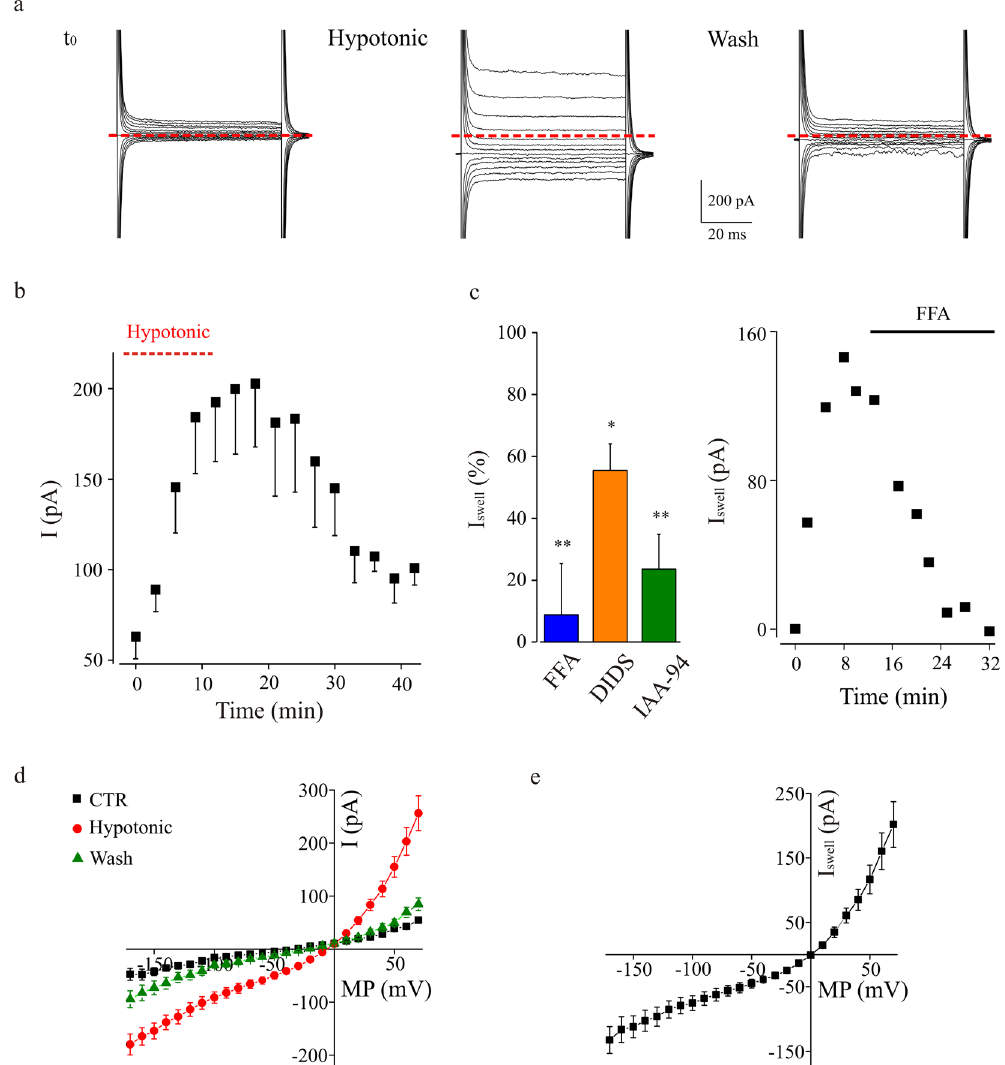
Figure 1. Induction of a swelling-activated current by hypotonic stimulation in microglia from acute hippocampal slices. ( a ) Whole-cell currents recorded from a microglia cell in acute hippocampal slice (HP = − 70 mV; test potentials from − 170 to + 70 mV; 10 mV increments), chronically exposed to a hypotonic extracellular solution (8–10% dilution). Left, current traces recorded after the establishment of the whole cell configuration (t 0 ); middle, currents recorded after 12 minutes of hypotonic stimulation (Hypotonic); right: currents traces recorded after 21 minutes of washout in normotonic solution (Wash). The zero current level is indicated by dotted red line. ( b ) Time course of swell-induced current recorded in hippocampal microglia cells (n = 6). Changes in amplitude (measured at + 50 mV) are plotted against time after establishment of the whole- cell configuration. ( c ) Left: bar chart representing the reduction of swell-activated current caused by slices superfusion with flufenamic acid (FFA, 200 μ M; n = 7; blue bar), diisothiocyanatostilbene-2,2 ′ -disolfonic acid (DIDS, 150 μ M; n = 4; orange bar), or indanyloxyacetic acid 94 (IAA-94, 500 μ M; n = 5; green bar), respectively. * p < 0.05 and ** p < 0.01 vs control, t-test. Right: representative time course of swell-activated current block by acute application of FFA. ( d ) Mean current-voltage relationships (n = 7) for the current recorded in control (black squares, CTR), after 18 minutes of acute hypotonic stimulation (red dots) and after washout (green triangles). ( e ) Average current-voltage relationship (n = 7) of the swell-activated current recorded in microglia cells from acute hippocampal slices under acute hypotonic stimulation. The current was isolated by subtraction of the current amplitudes measured prior to hypotonic stimulus from those at 18 minutes of hypotonic